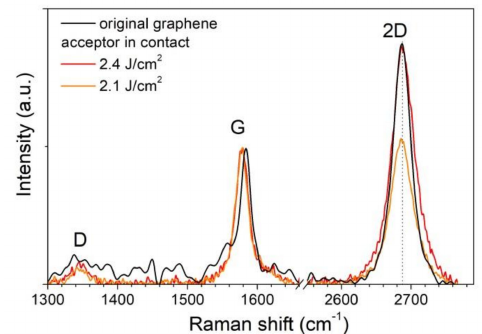
Figure 5. Raman spectra of the graphene films, recorded from the initial film on the donor substrate and areas on the acceptor substrates after the transfer procedure with zero distance between substrates.